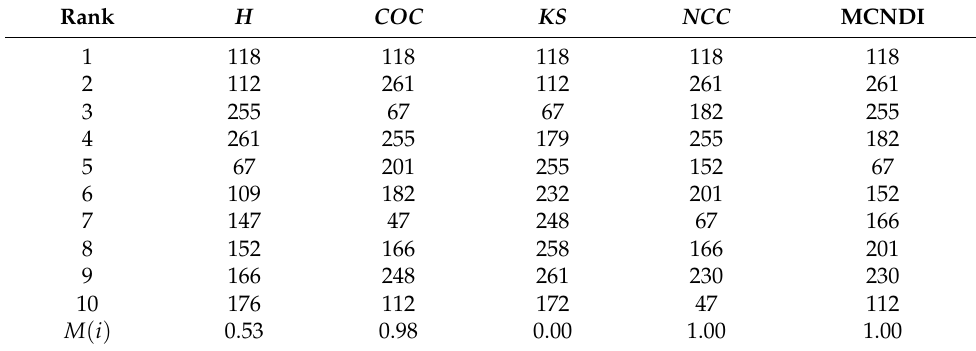
Table 1. USAir97 network.